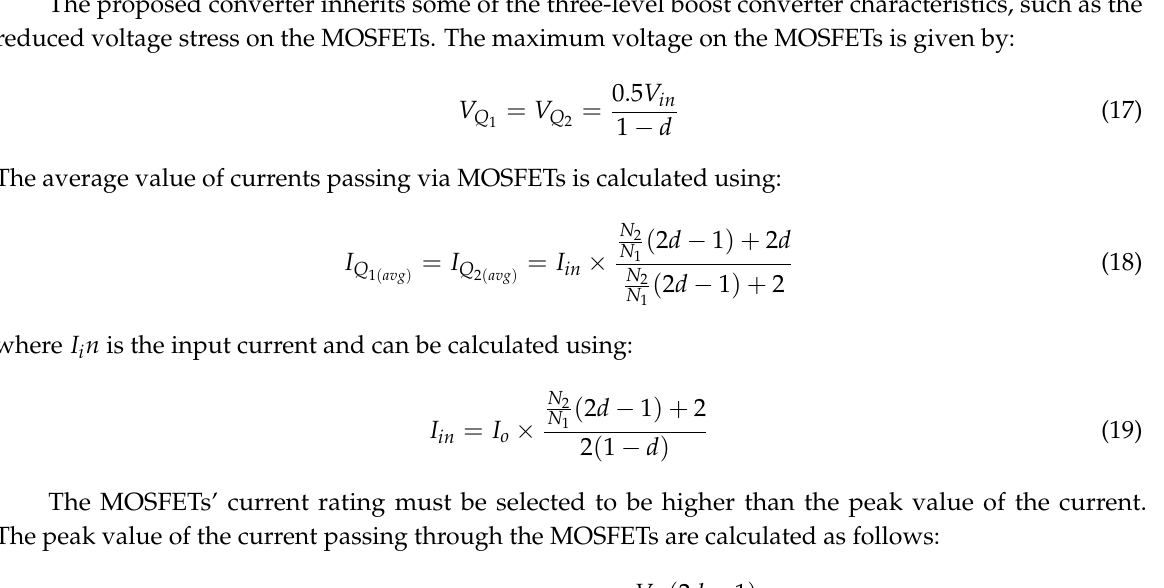
Figure 7. The voltage gain of the three-level boost converter with flyback transformer: ( a ) effect of the turns ratio and duty cycle; ( b ) the voltage gain of the introduced converter compared to other